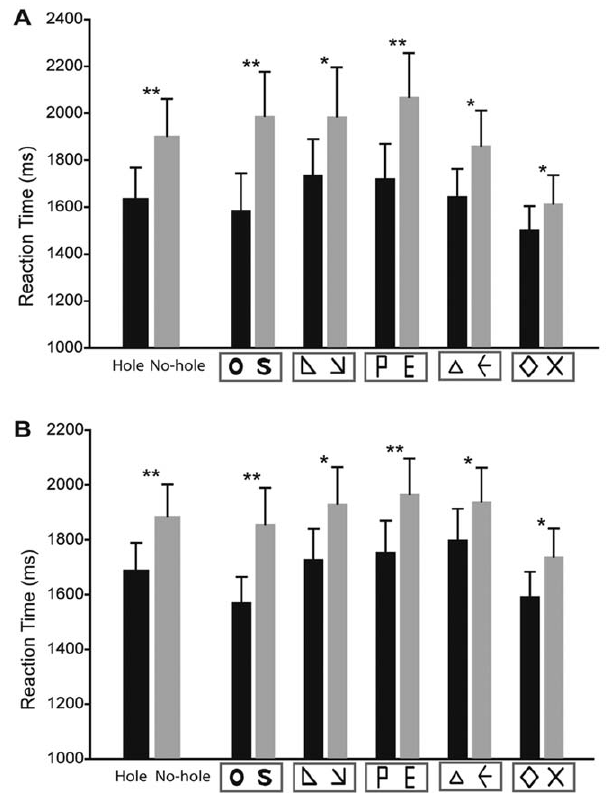
Figure 2. Results of Exp 1 and 2. (A) The average reaction times for the ‘‘hole’’ and ‘‘no-hole’’ stimuli in Experiment 1. (B) The average reaction times for the ‘‘hole’’ and ‘‘no-hole’’ stimuli in Experiment 2. * p , 0.01; ** p , 0.002.